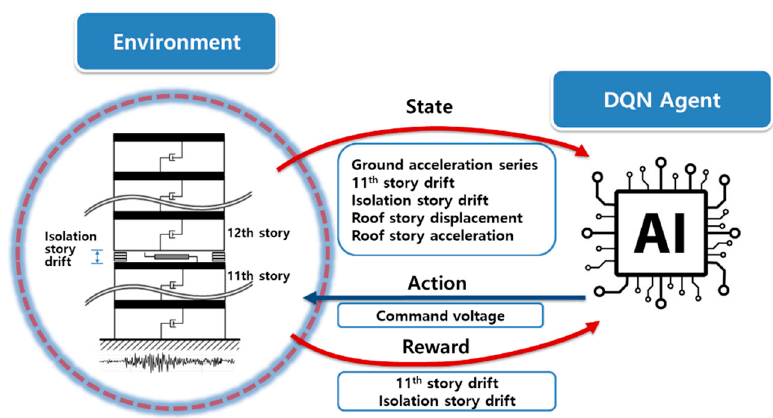
Figure 8. Configuration of the DQN agent and environment.